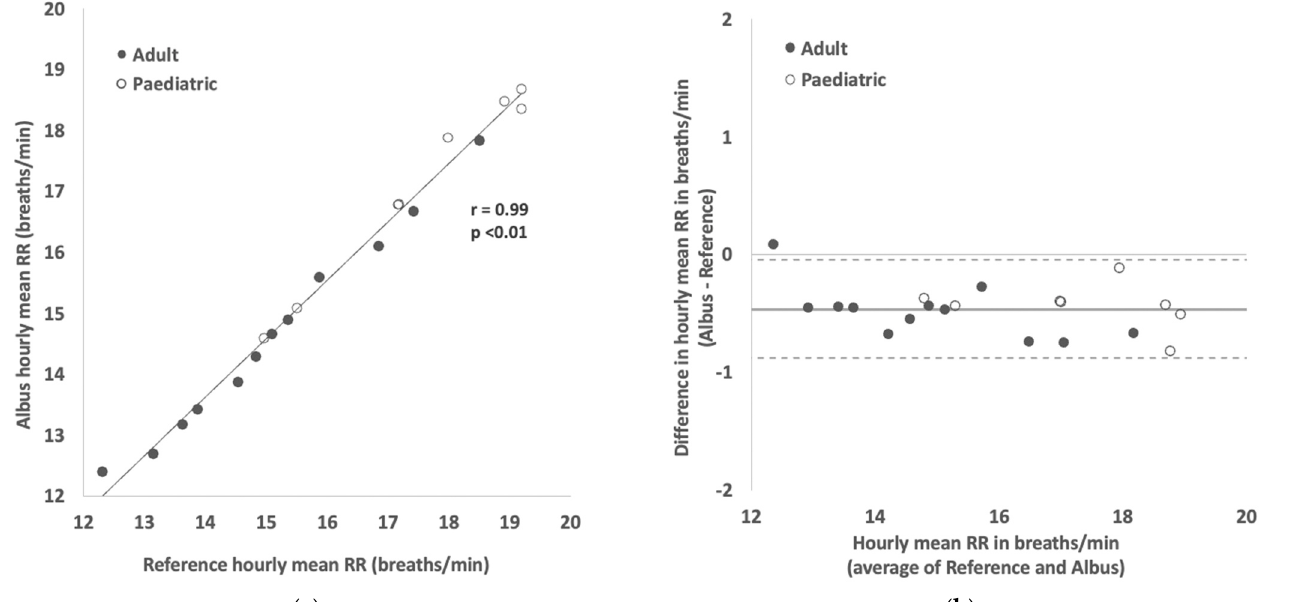
Figure 3. ( a ) Scatter plot showing correlation between hourly mean RR readings between Albus system and reference (clinician-counted polygraphy). ( b ) Bland–Altman plot showing agreement in hourly mean RR readings between Albus system and reference (solid line shows mean difference of − 0.46 breaths/min and dotted lines show 95% limits of agreement from 0.04 to − 0.88 breaths/min). There are, in total, 20 comparisons across 10 participants, with each point depicting a mean RR reading for a 1-h period.